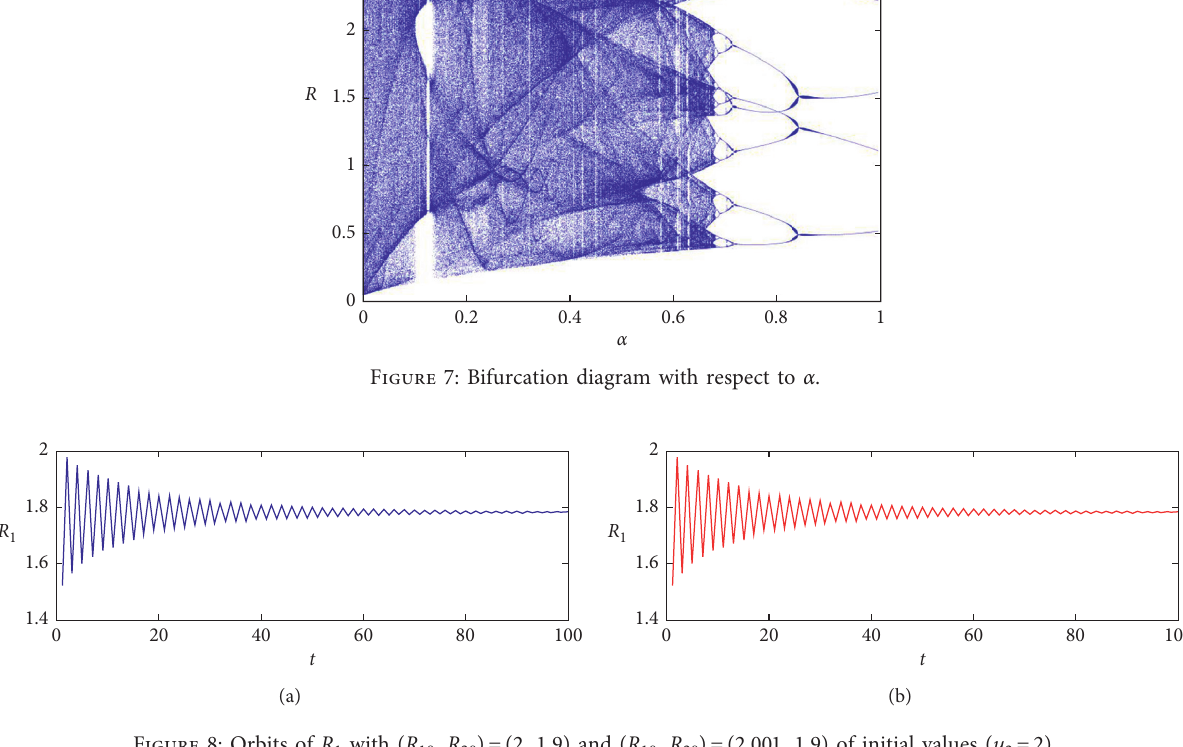
1 with ( R 10 , R 20 )